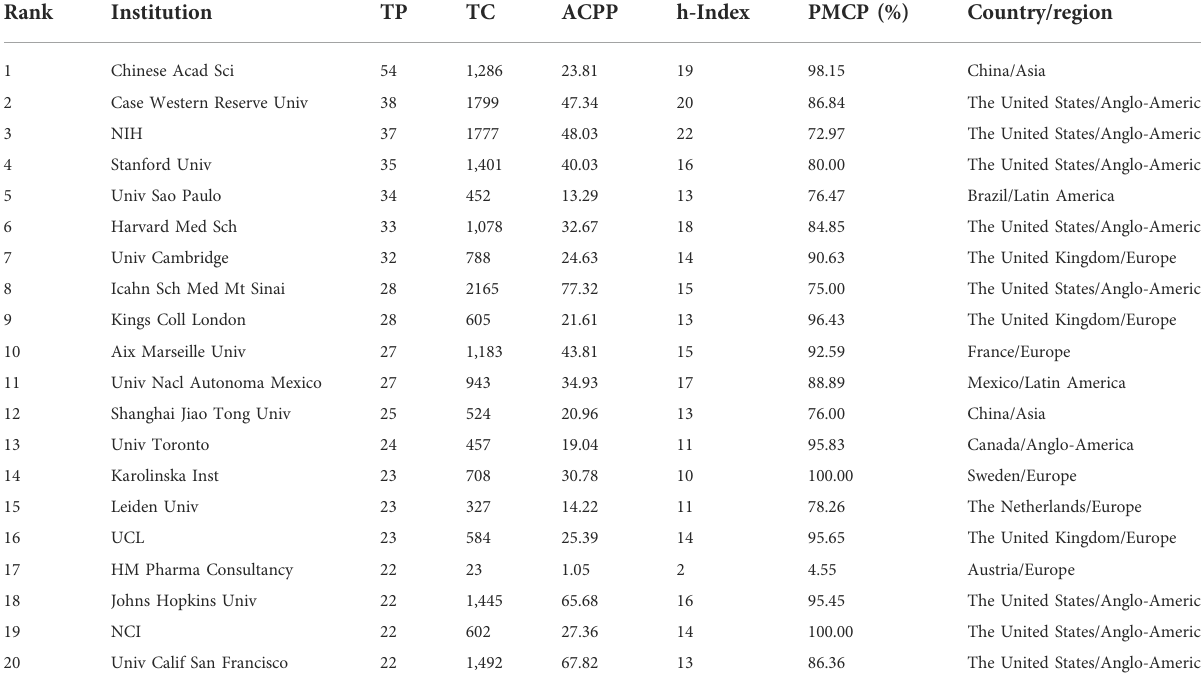
TABLE 2 Top 20 most productive institutions in the fi eld of drug repositioning for the period of 2010 – 2020.